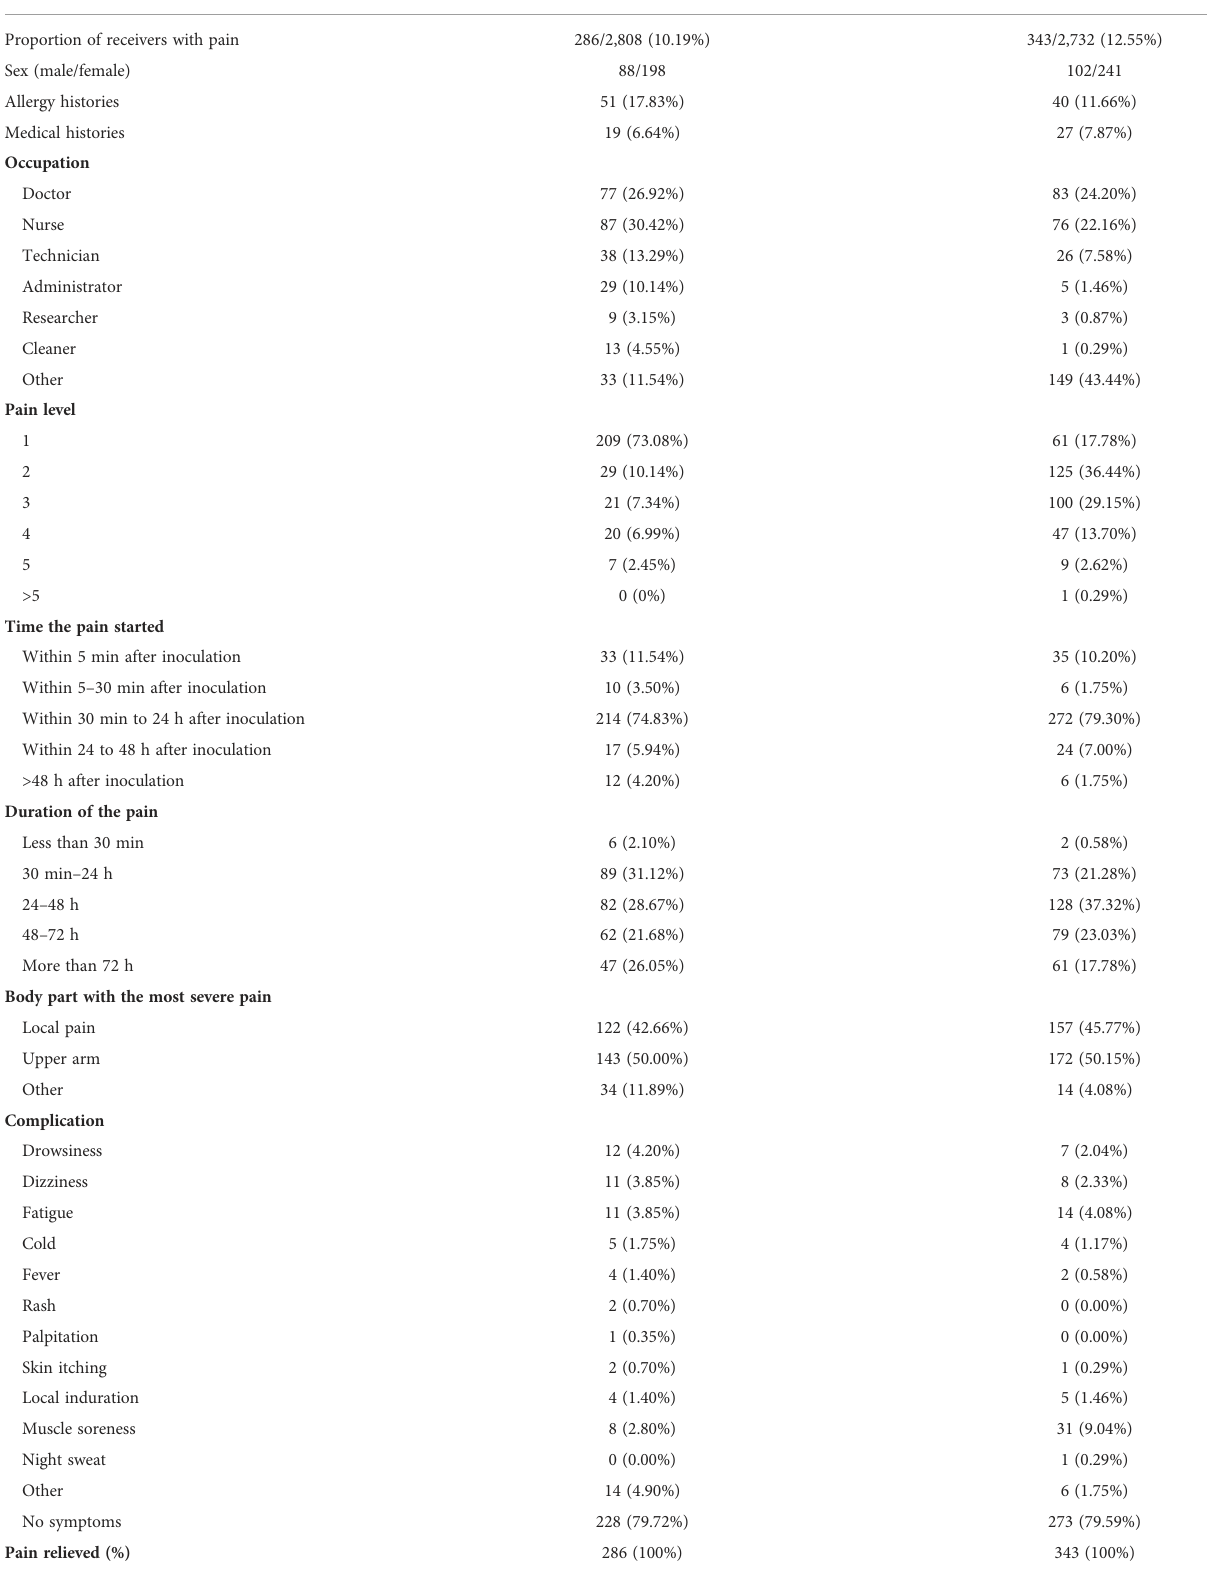
TABLE 3 Characteristics of receivers with pain following